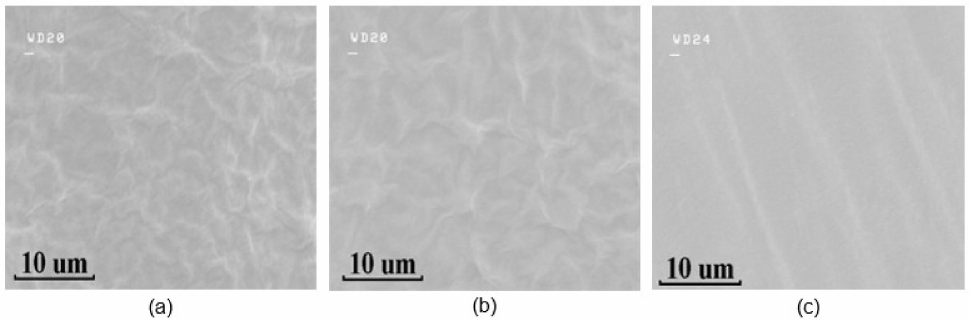
Figure 4. SEM images of GO on different substrates: ( a ) bare hydrophobic PTFE, ( b ) ethanol-treated hydrophobic PTFE, ( c ) hydrophilic